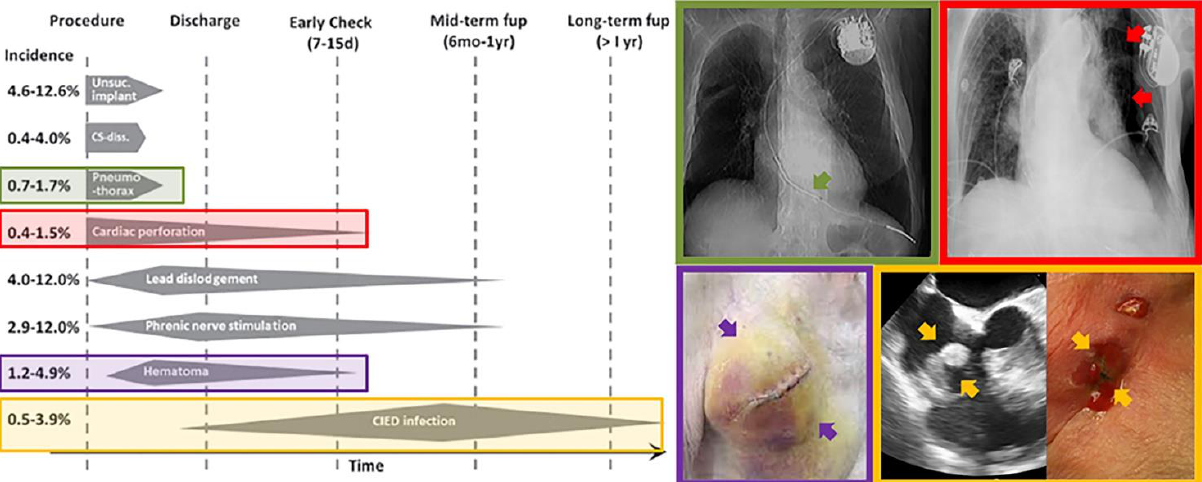
Figure 1. Incidence and common periods of greater vulnerability to complications of cardiac resynchronization implants or upgrades. Modified from “Cardiac resynchronization therapy in the real world: need to upgrade outcome research” by